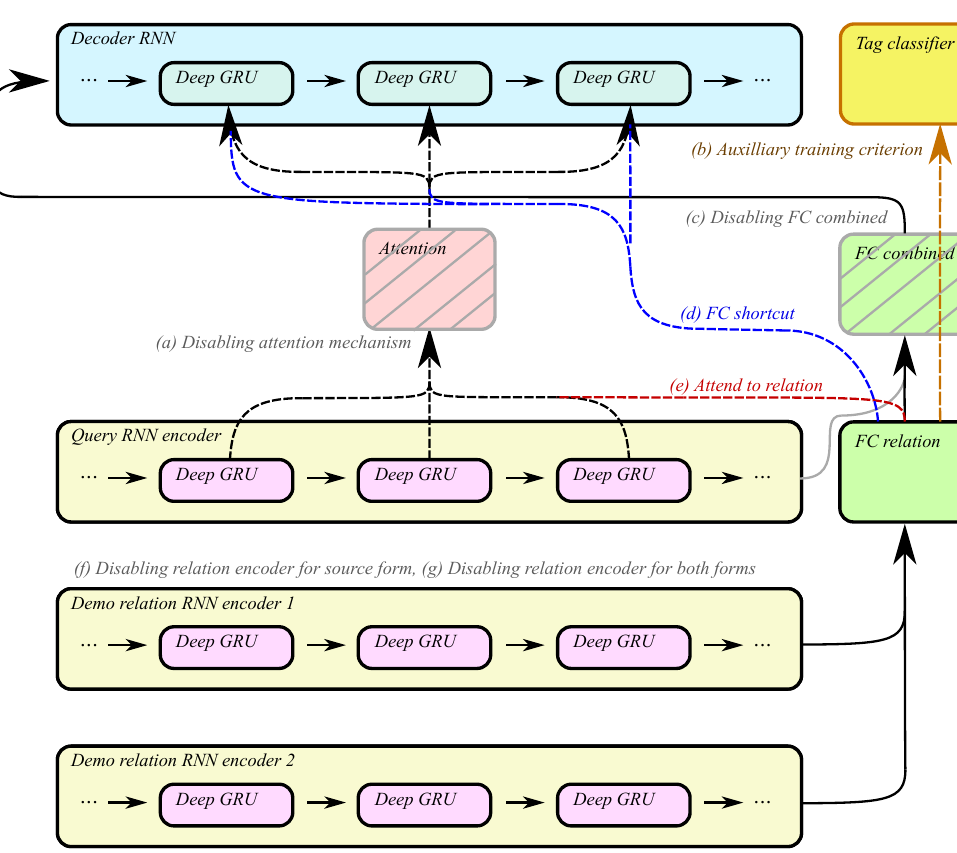
Figure 2: The evaluated variants of the proposed model. (a) disabling attention mechanism, (b) auxiliary training criterion, (c) disabling FC combined, (d) FC shortcut, (e) attend to relation, (f) disabling relation encoder for source form, and (g) disabling relation encoder for both